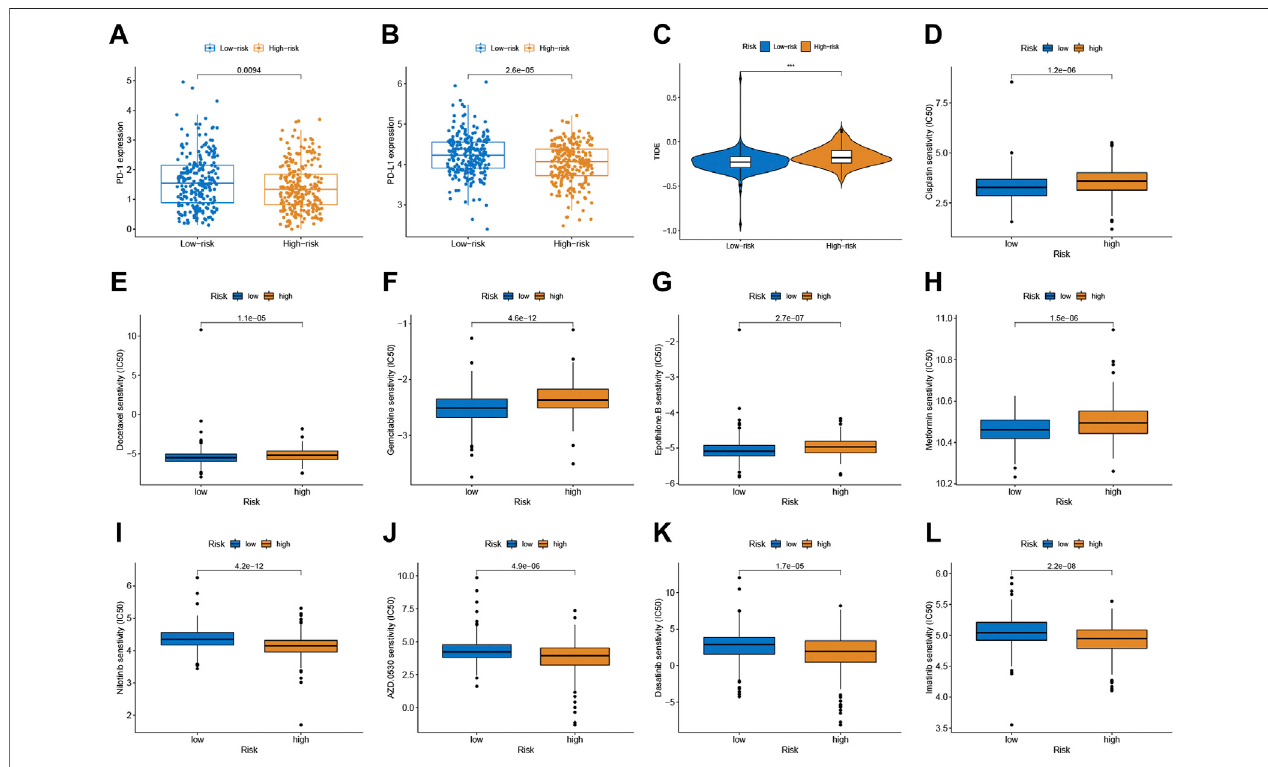
FIGURE 6 | Functional enrichment analysis between low- and high-risk groups. The top fi ve signaling pathways in the high- (A) and low-risk subgroup (B) .